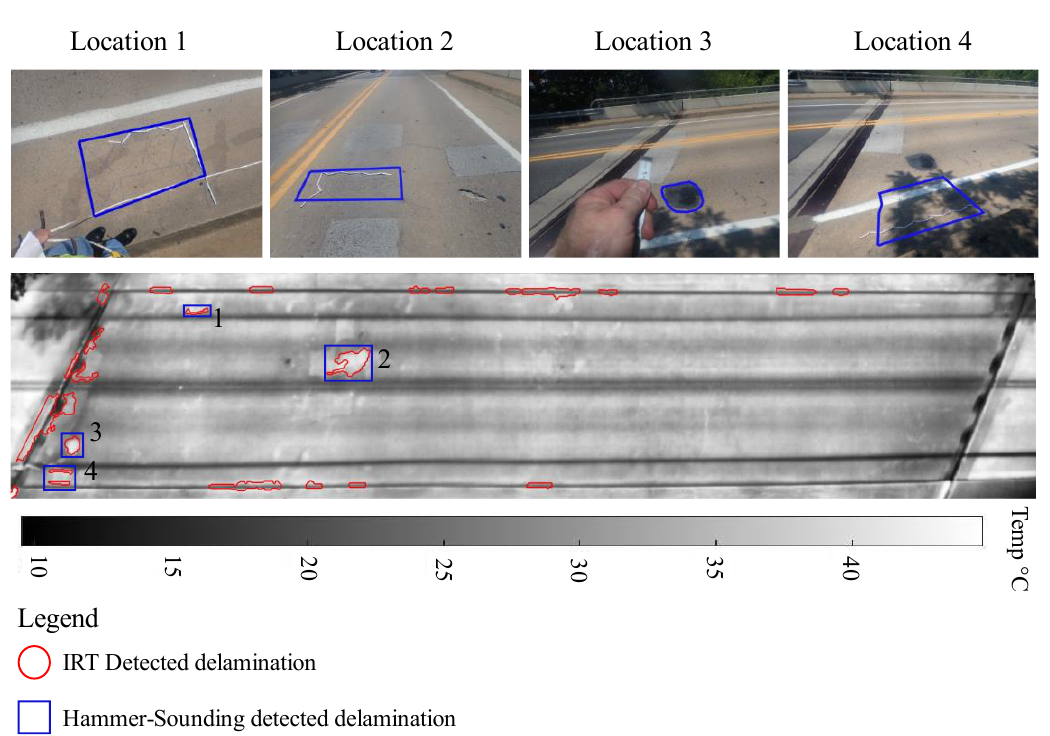
Figure 15. Delaware bridge level-set thermal image results with a boundary threshold of 0.4.